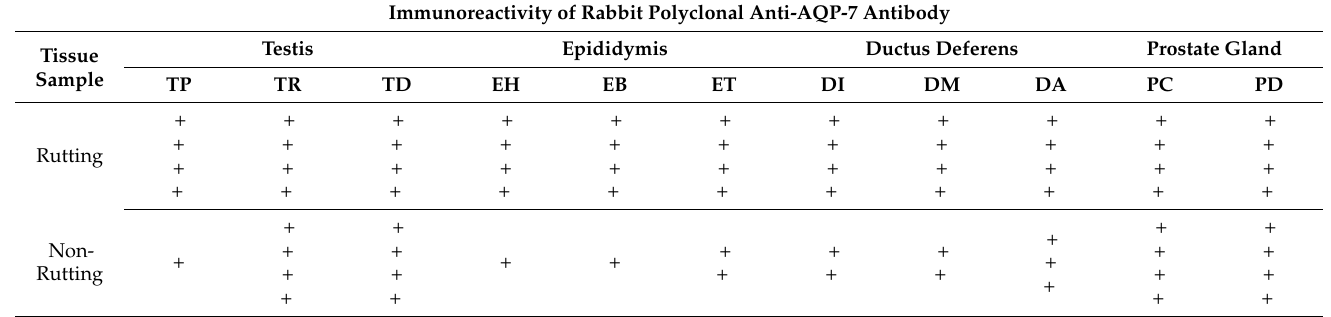
Table 3. The semi-quantitatively immunohistochemical reactivity to anti-AQP-7 antibody in testis, epididymis, ductus deferens, prostate and bulbourethral gland.